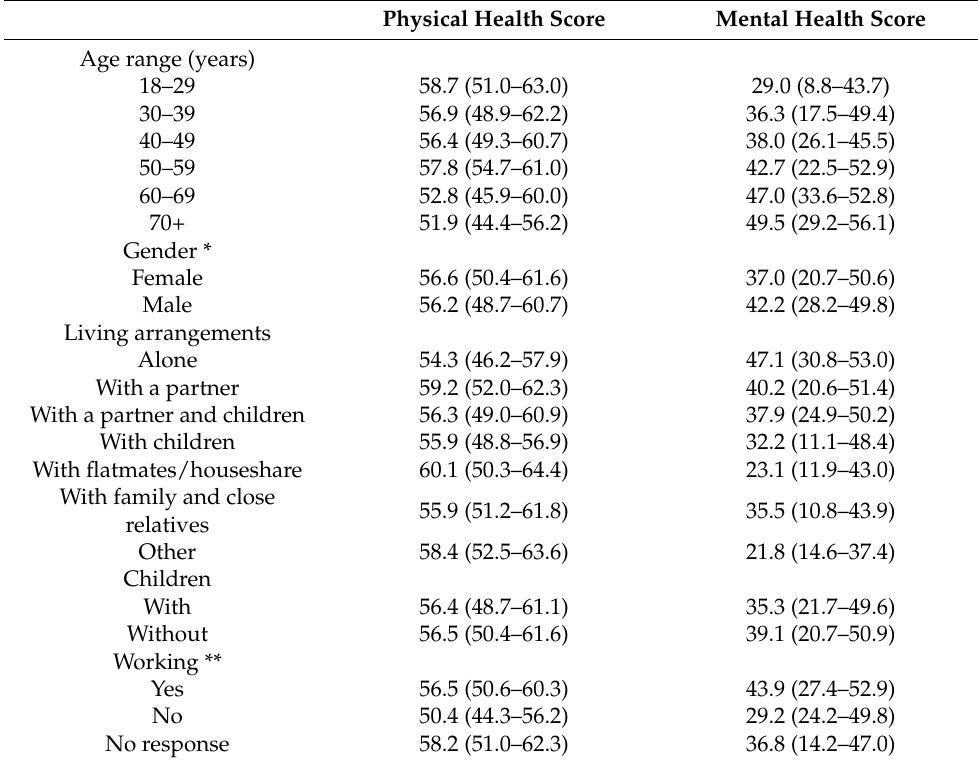
Table 4. Quality of life physical and mental health scores as measured using the